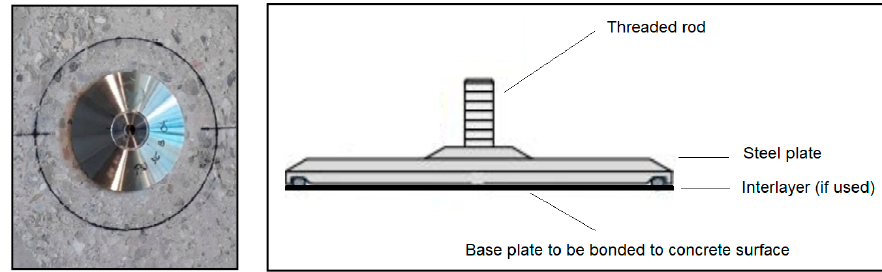
Figure 1. Example of C-BlockTM bonded on concrete.